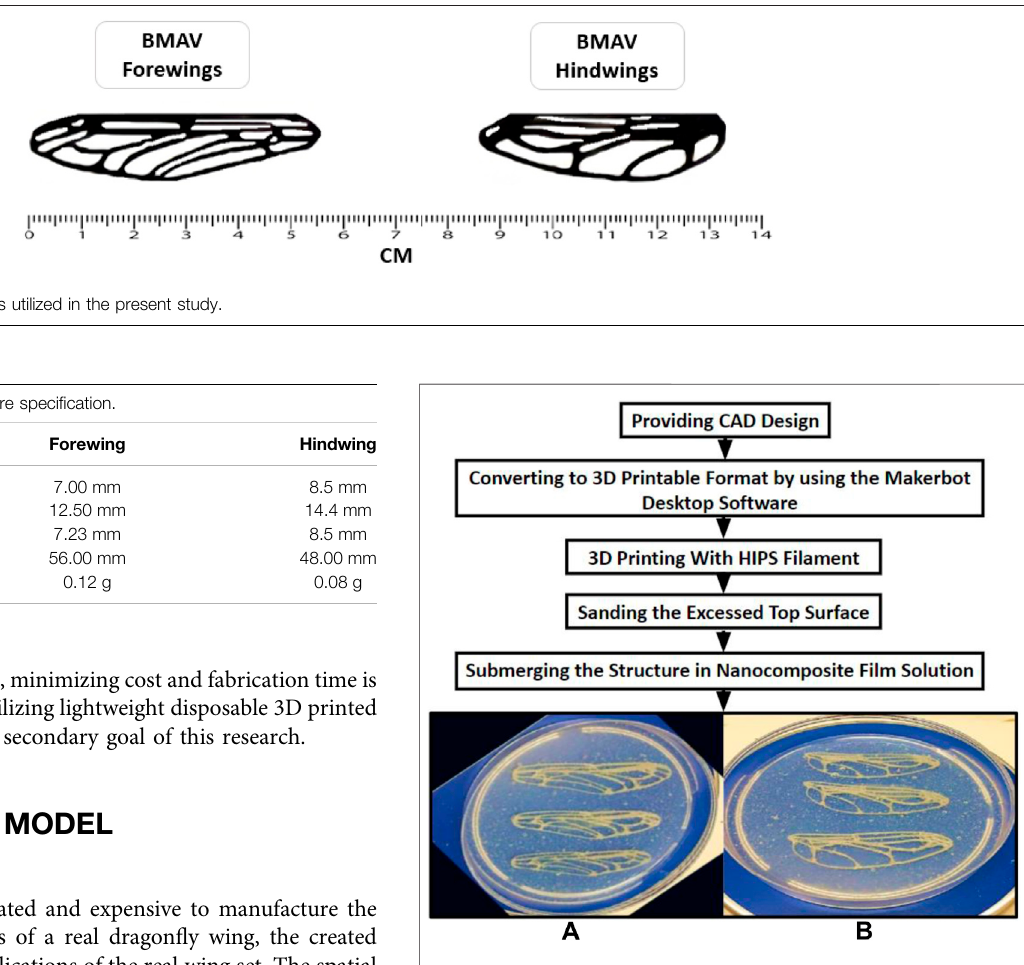
FIGURE 2 | Design process: (A) Forewing, (B)